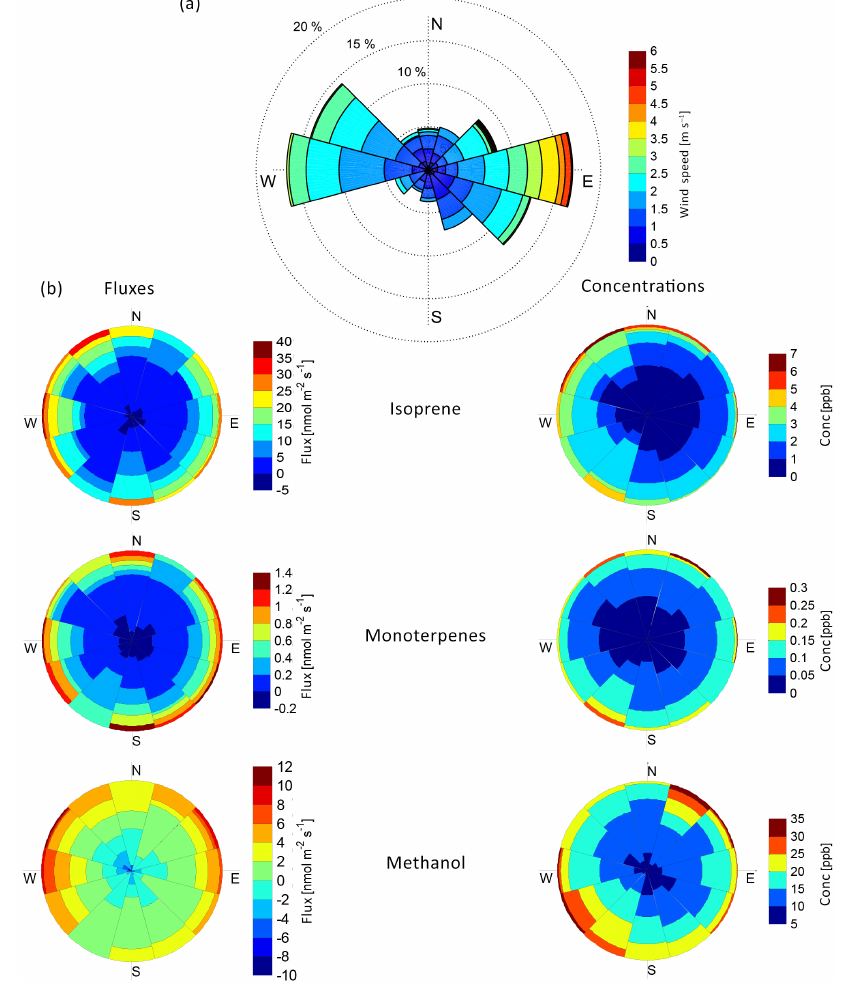
Figure 7. (a) Wind rose of the wind speed. The percentages describe how often the wind came from the selected wind direction. (b) Unscaled wind roses for fluxes (left) and concentrations (right) of isoprene (top), monoterpenes (middle), and methanol